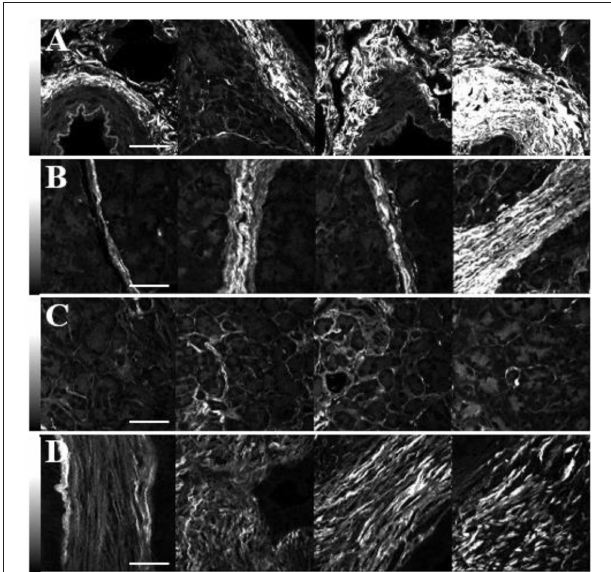
FIGURE 2 | SHG intensity comparison of collagen in the periductal (A) , lobular (B) and parenchymal (C) regions of normal pancreas as well as in tumor (D) . The imaging laser was circularly polarized and identical conditions were used for all the images. The scale bars represent 50 µ m, and the intensity scale bars represent the SHG signal in each